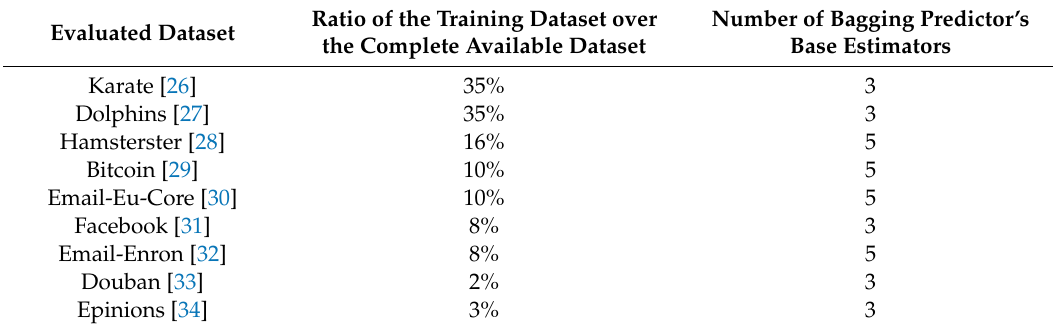
Table 3. Execution parameters applied per evaluated